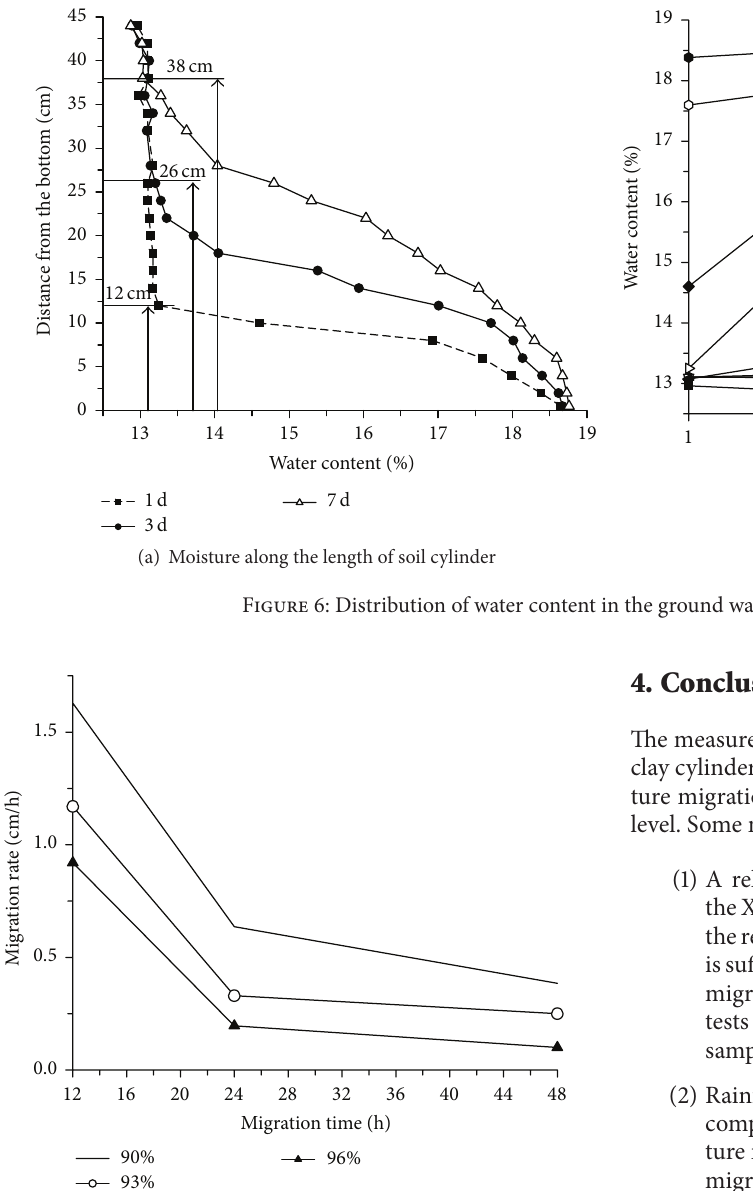
Figure 7: Migration rate of rainfall test with different compaction